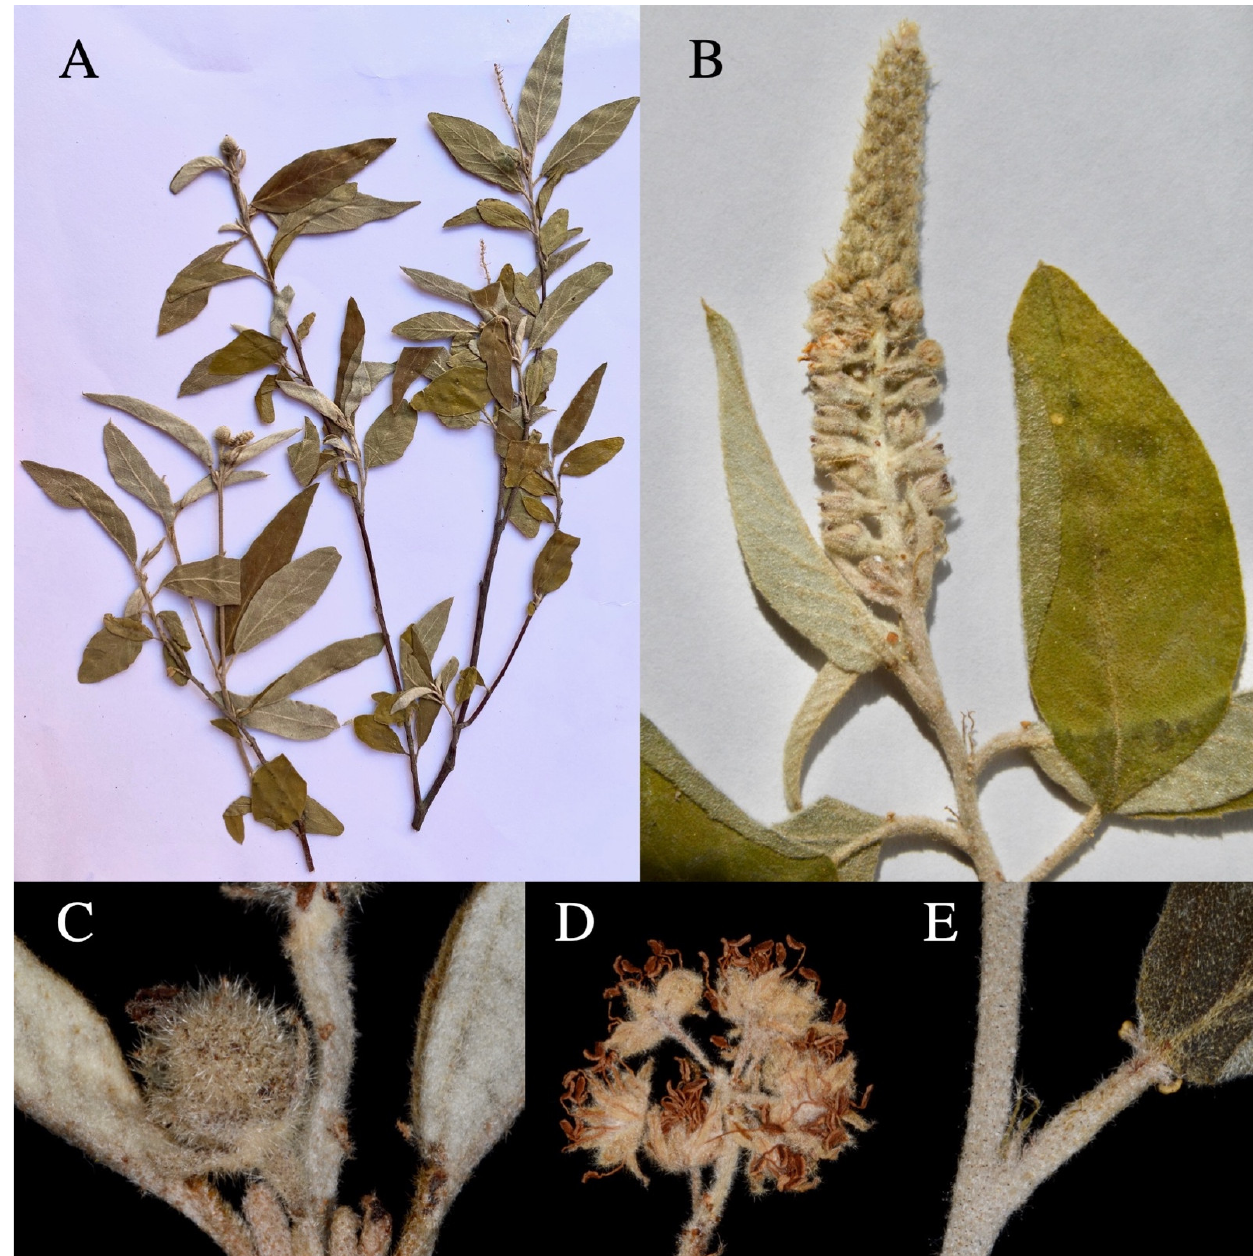
Figure A14. Croton aff. ramillatus . ( A ). Fruiting branches. ( B ) Branch with inflorescence. ( C ) Young fruit. ( D ) Stami- nate flowers. ( E ) Lower leaf blade and extrafloral nectaries. ( A ), ( B ), and ( D ) from Steinmann 5193 ; ( C ) and ( E ) from Steinmann 4345